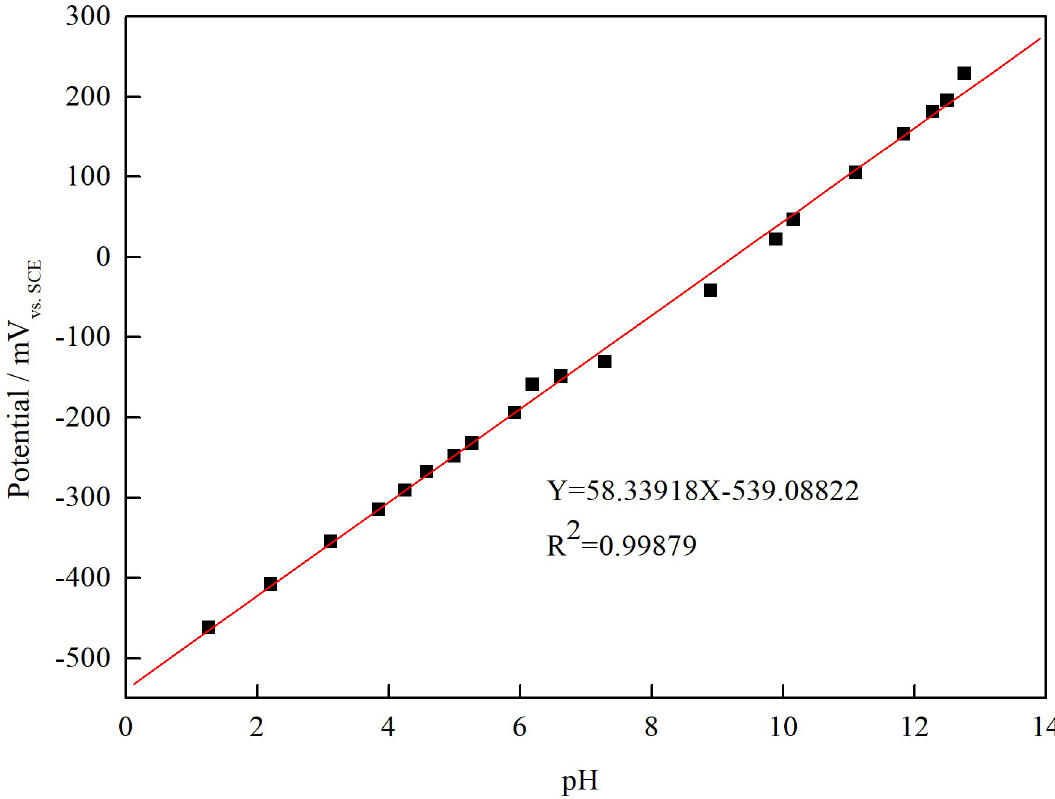
Fig 1. Variations of potential with pH for the Ir/IrO 2